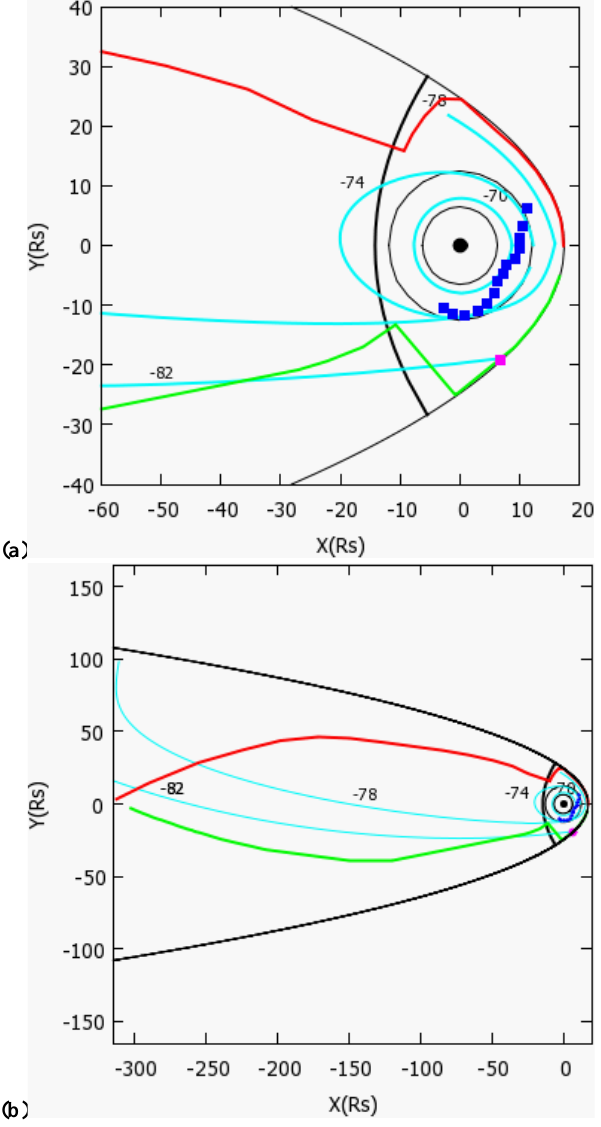
Fig. 10. Mappings of field lines into the KSM equatorial plane for image A with k s = 0 . 2, in a format similar to Fig. 6. Panel (a) shows the near-planet region exactly as in Fig. 6, while panel (b) shows a larger region extending into the magnetospheric tail. The closed field region is contained between the red and green lines, where the former is projected from the Southern Hemisphere and the latter from the